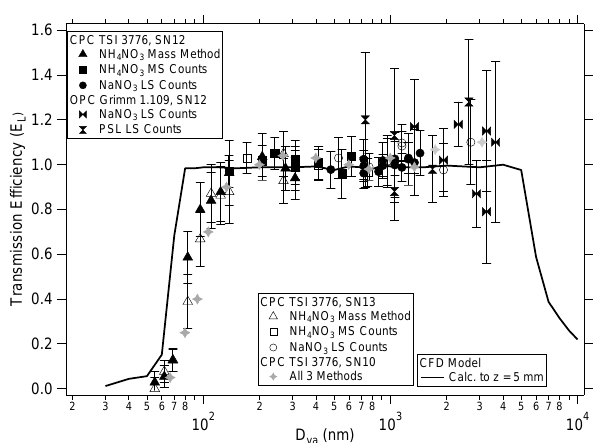
Fig. 4. Experimentally determined transmission efficiency ( E L ) as a function of particle size for three examples of the HPL (SN10, SN12 and SN13), using the mass method (triangles) and the count method (other symbols). Particles entering the AMS were counted with a CPC or an OPC, and particles transmitted by the lens system were measured with the mass spectrometer or with light scattering signals. The CFD calculation (extending to z = 5mm past the exit nozzle) is shown with the solid